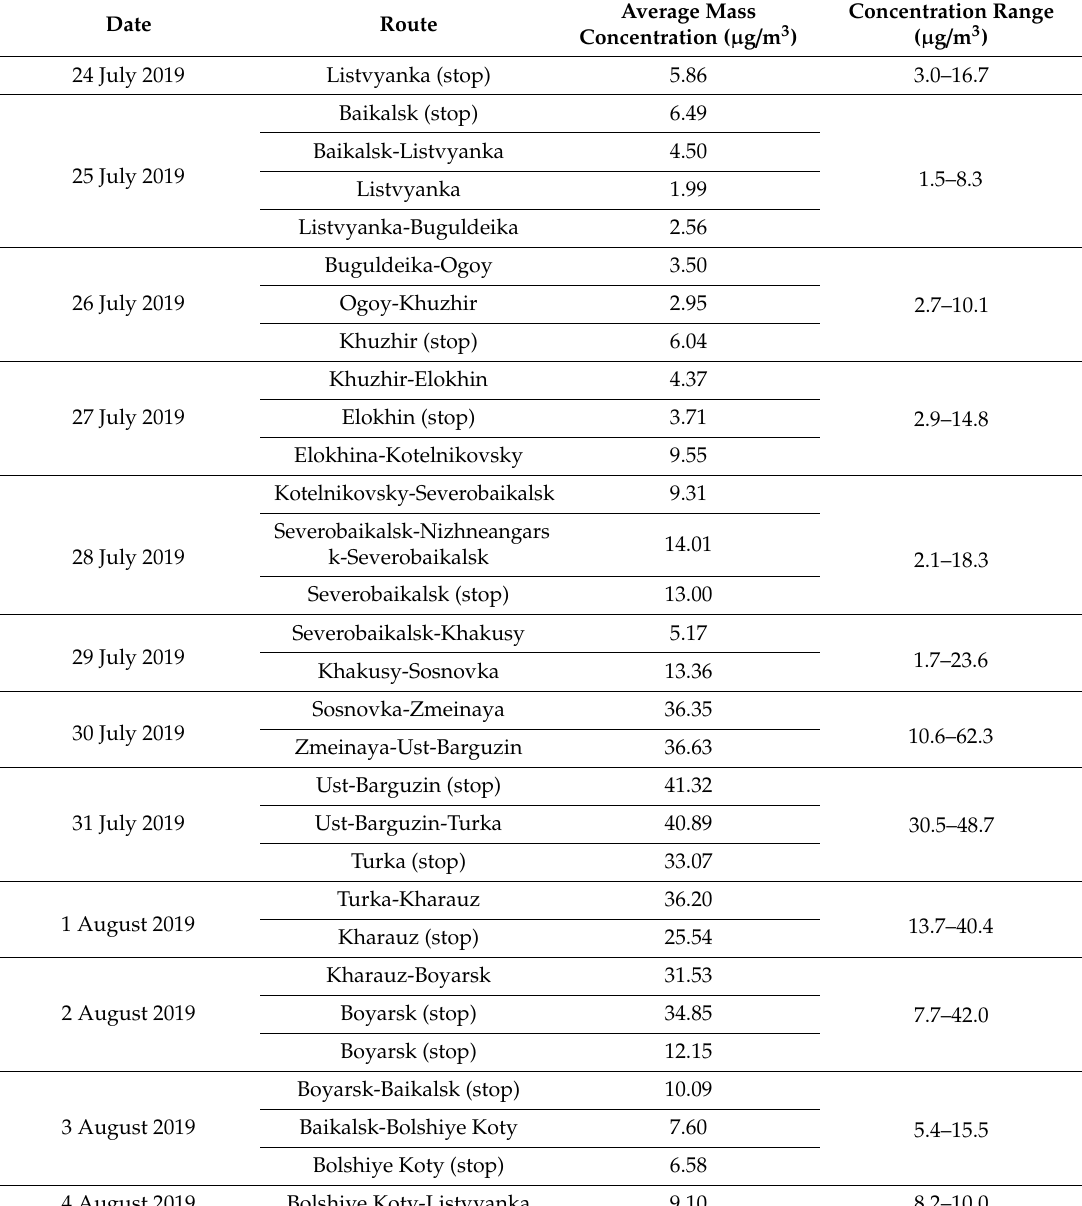
Table 1. The average mass concentrations of aerosol particles along the RV route in